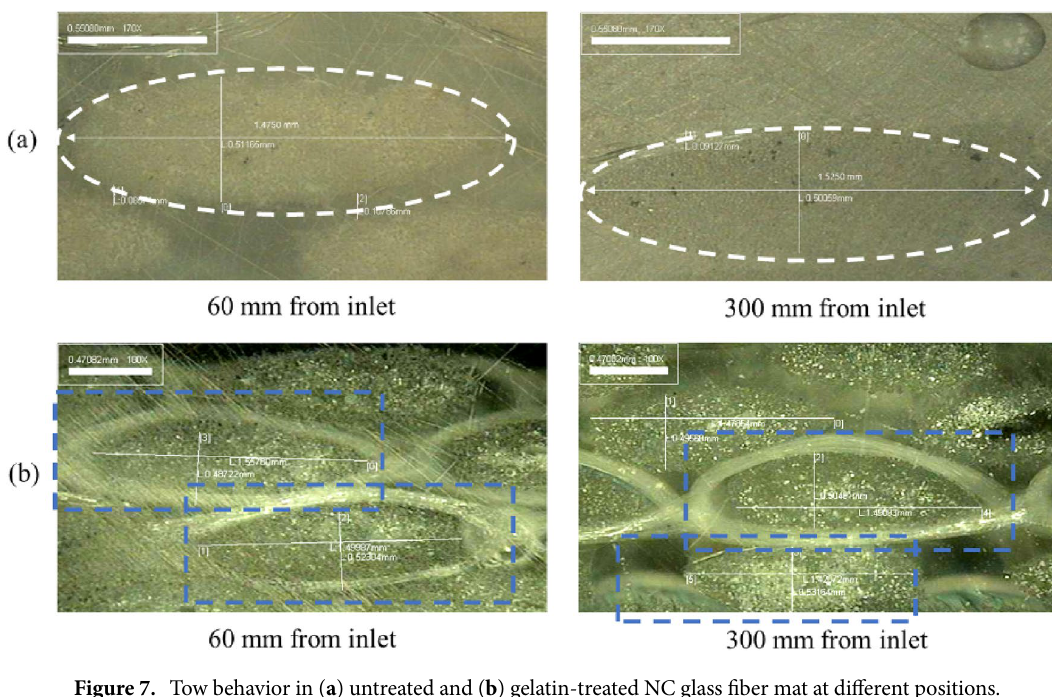
Figure 7. Tow behavior in ( a ) untreated and ( b ) gelatin-treated NC glass fiber mat at different positions.